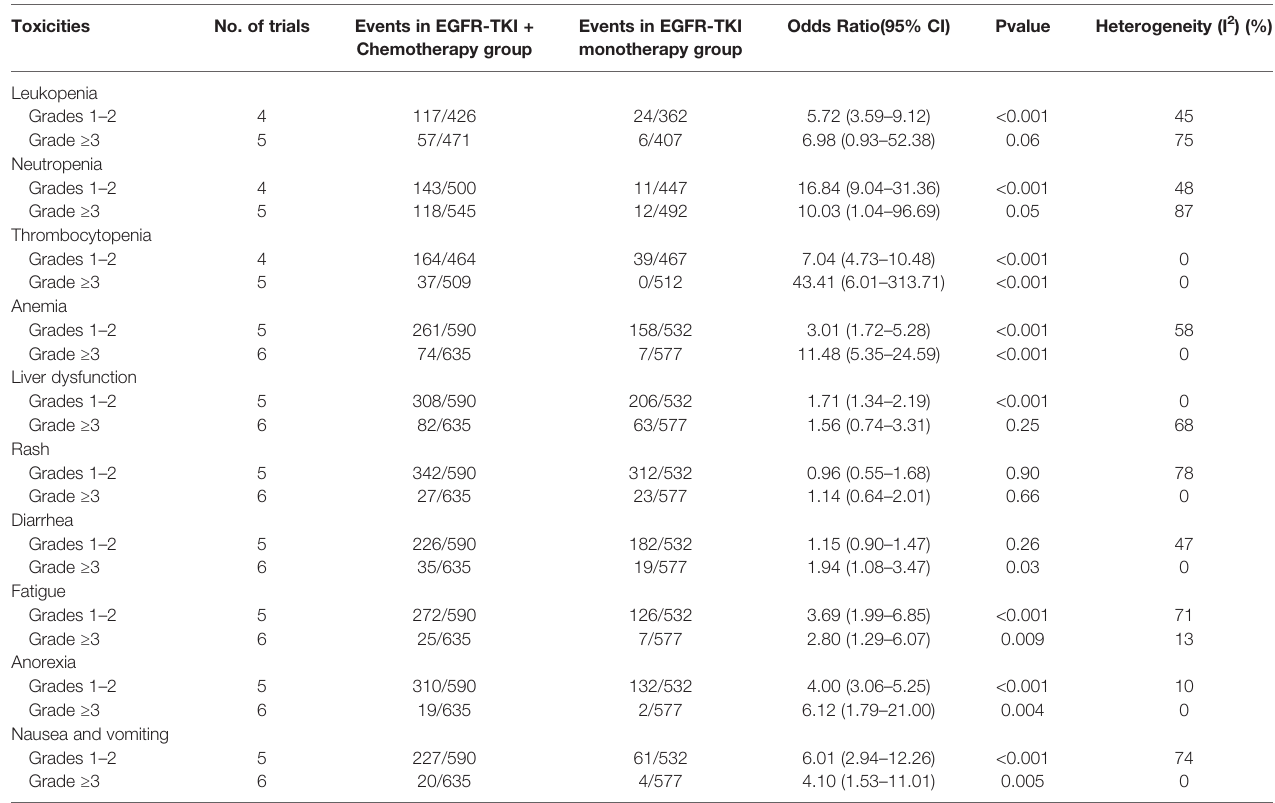
TABLE 2 | Pooled odds ratio of toxicities in included randomized